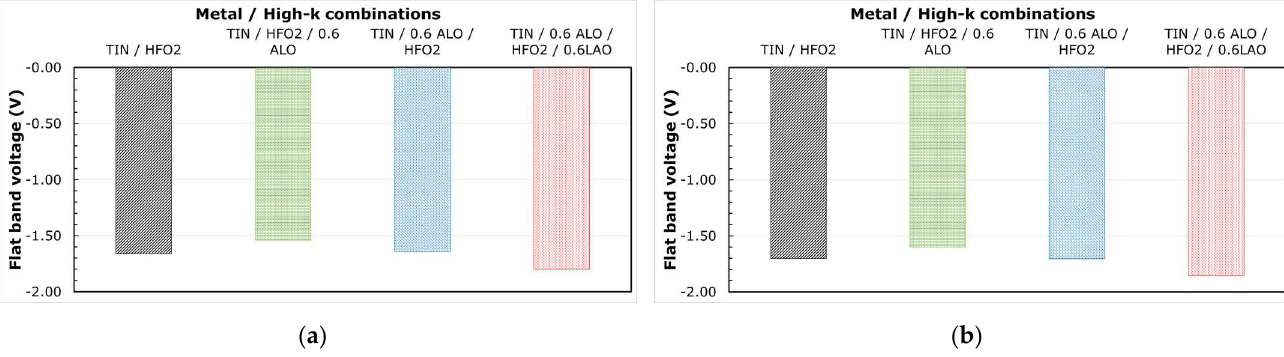
Figure 16. Flat band voltage monitored from CV traces, for MHONOS stacks with different dipole interlayers from Figure 15 ( a ) without any PMA and ( b ) with PMA for 20 min at 750 °C in N 2 ambient.